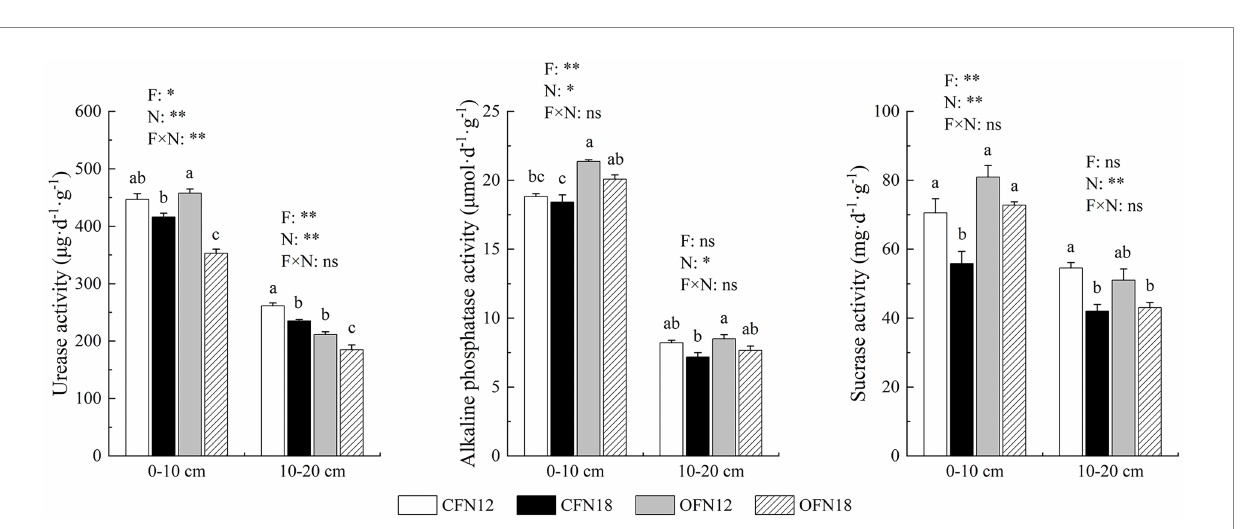
Data are presented by mean value ± SD. Different lower case letters in the same column indicate significant differences among the four treatments at p < 0.05. TN, total nitrogen; AN, alkali- hydrolyzable nitrogen; AP, available phosphorus; AK, available potassium; SOM, soil organic matter. The same below.